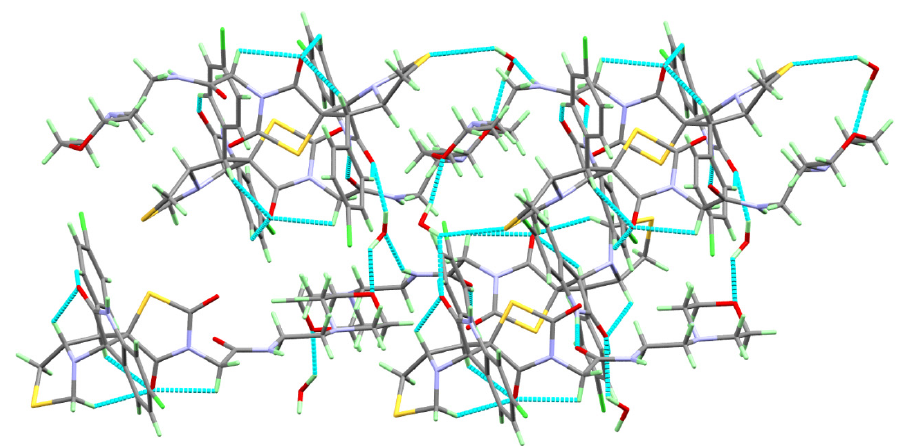
Figure 2. Packing of molecular units via hydrogen bonding interactions in compound 5a .